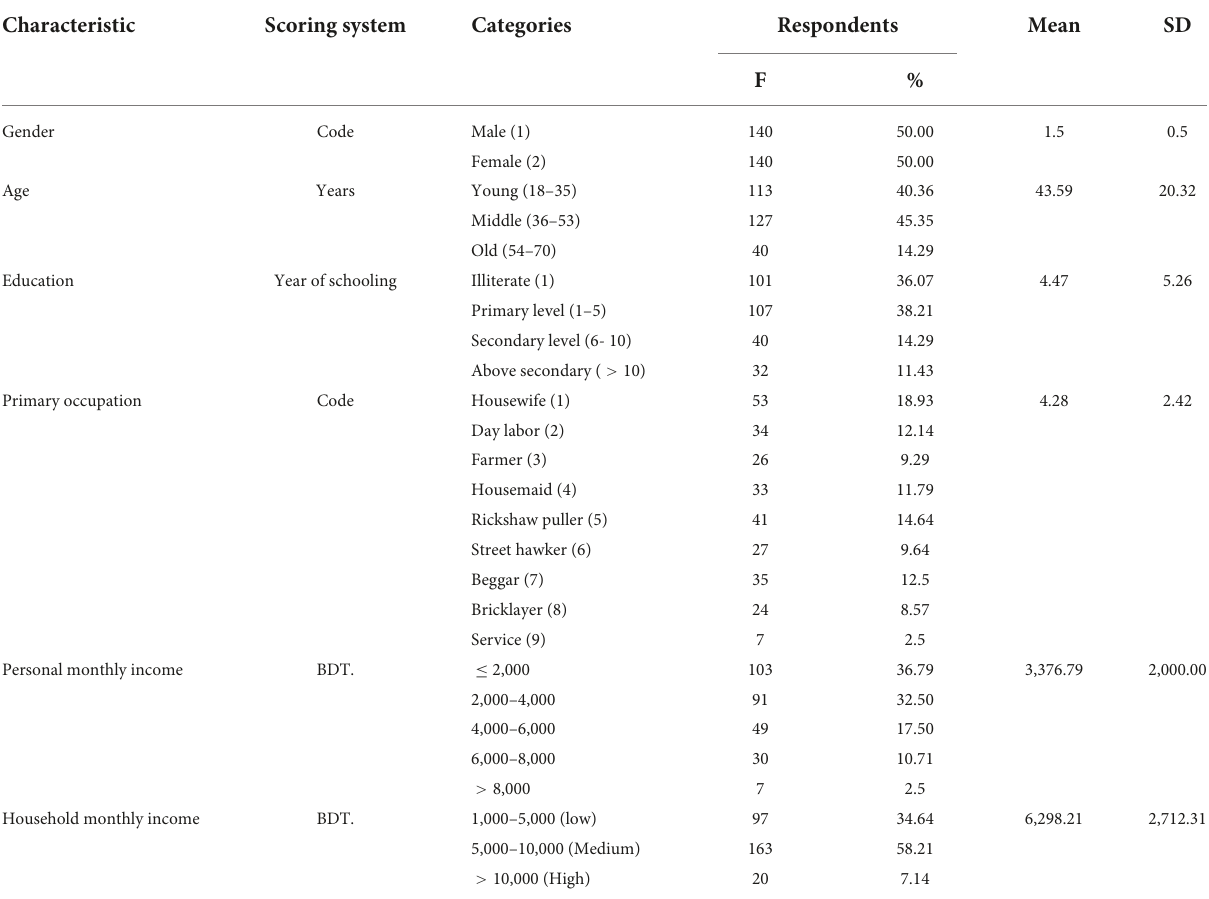
TABLE 1 Socioeconomic characteristics of the